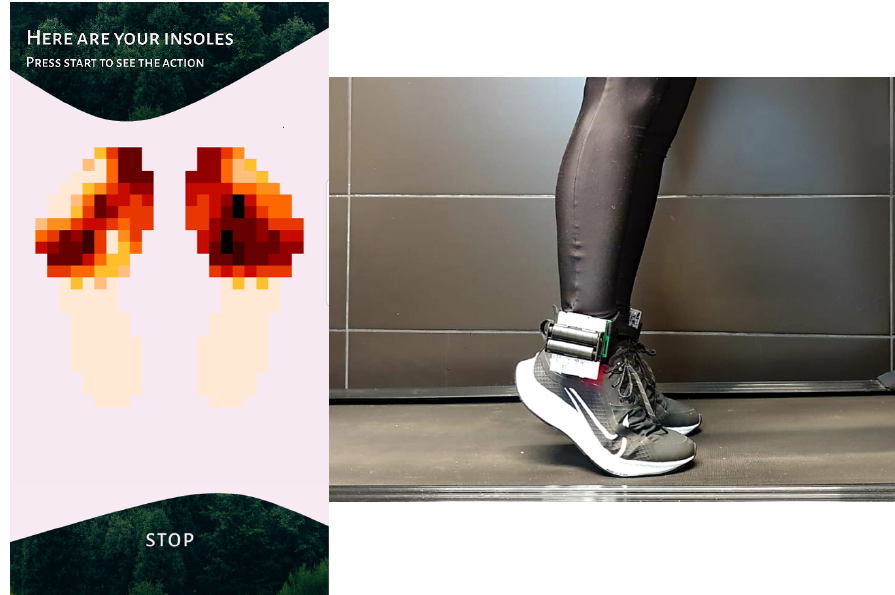
Figure 20. Test example of pressure distribution. Table 4. Results of system tests (scale 1–5, where 1—very bad, and 5—very